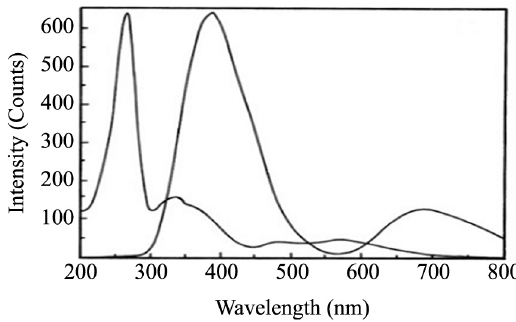
Figure 6. Representative RT-PL of the as-synthesized In by calcination of sample